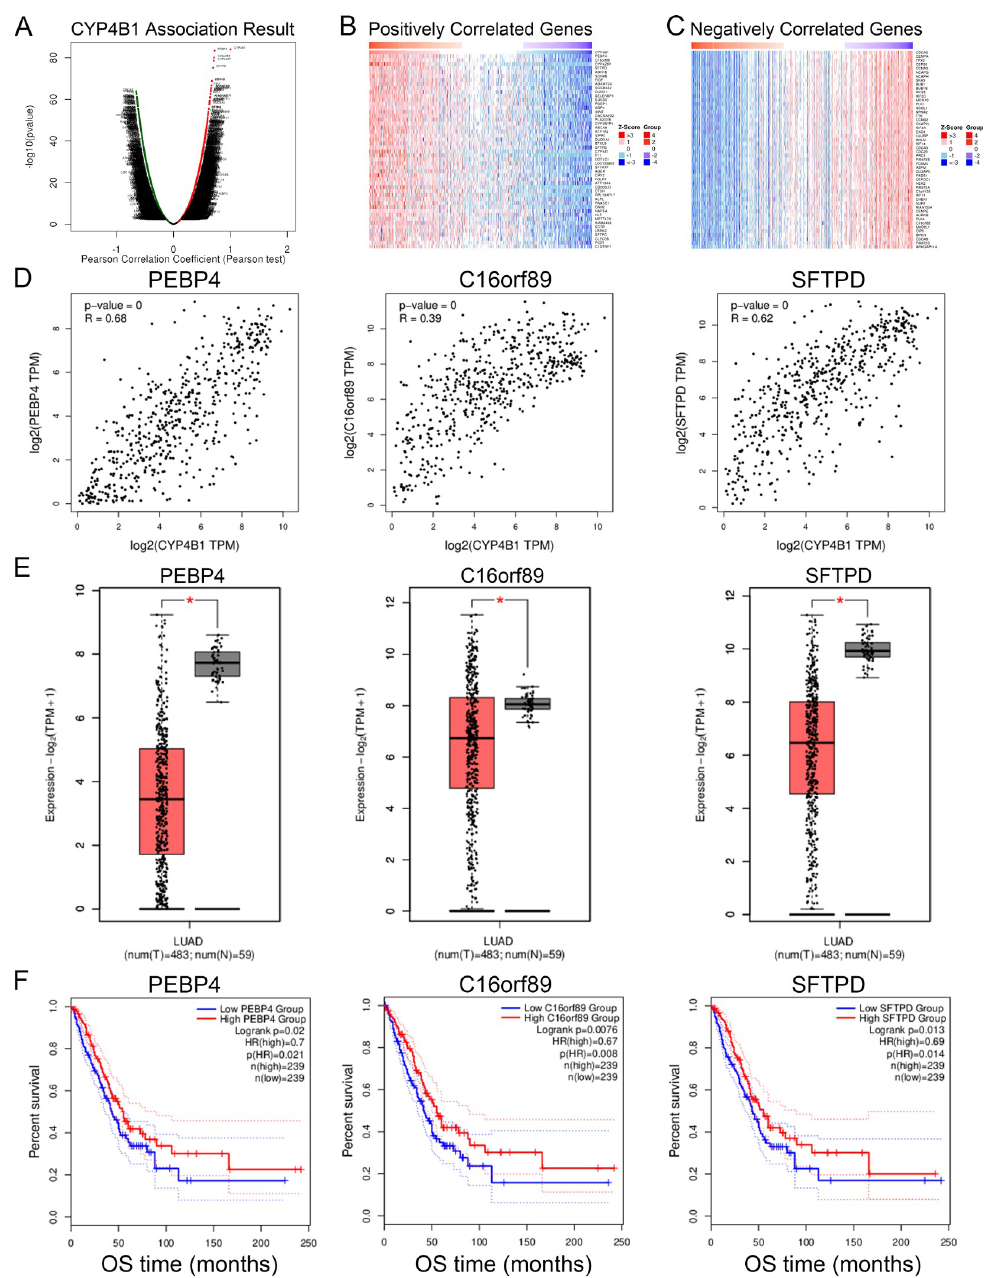
Fig 5. Differentially expressed genes correlated with CYP4B1 in LUAD. (A) Volcano plot showing differentially expressed genes significantly associated with CYP4B1 (FDR < 0.05; |Pearson’s r| > 0.2). (B, C) Heatmaps showing the top 50 significant genes positively and negatively correlated with CYP4B1 in LUAD. (D-F) The top three significant genes demonstrating positive co-expression with CYP4B1 in LUAD. (D) Pearson correlation of CYP4B1 expression with PEBP4 , C16orf89 , and SFTPD . (E) The mRNA expression profiles of PEBP4 , C16orf89 , and SFTPD in LUAD tissues when compared with normal lung tissues. (F) Survival analysis of PEBP4 , C16orf89 , and SFTPD in LUAD. FDR, false discovery rate; LUAD, lung